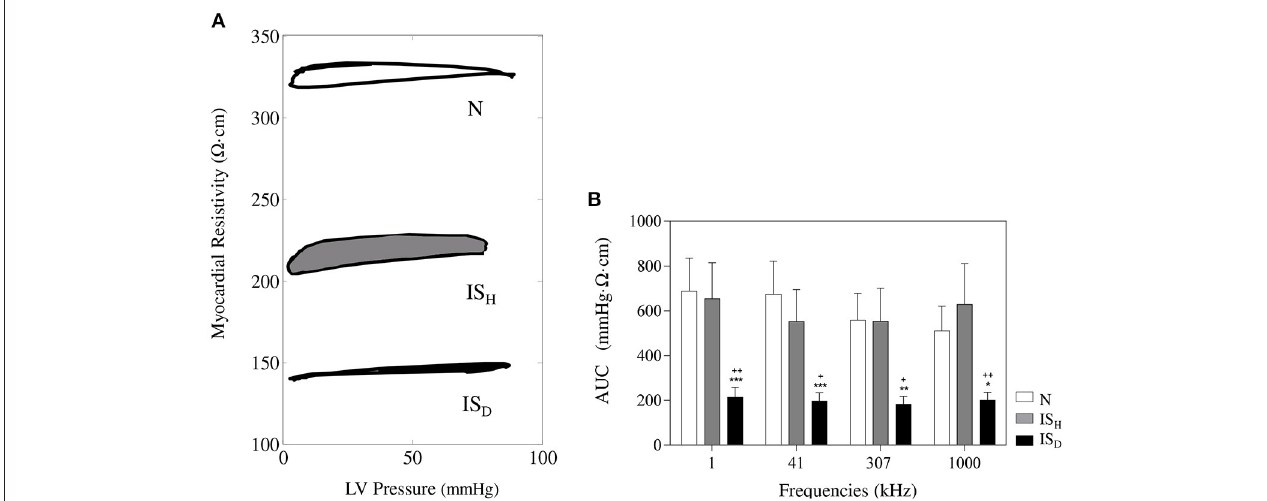
FIGURE 6 | Time relationship between the systolic-diastolic changes in myocardial impedance and left ventricular pressure. (A) Representative LV pressure-impedance curves at sites with < 10% of fibrosis (white), 10–50% of fibrosis (gray) and > 50% of fibrosis (black). (B) Mean values of the area under the curve at different current frequencies. *Significantly different from set N (* < 0.05, ** < 0.01, *** < 0.001). + Significantly different from set IS H ( + < 0.05, ++ <